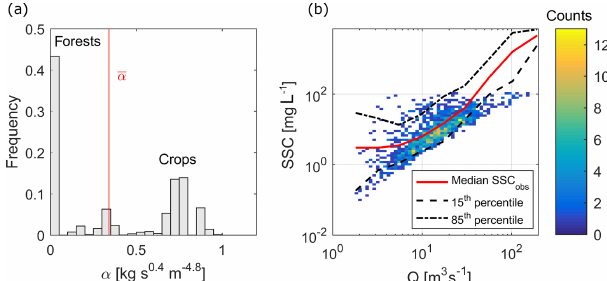
Figure 3. (a) Frequency distribution of the calibrated surface erodi- bility parameter α , with mean α indicated with the red line; (b) den- sity plot of the simulated SSC at outlet compared with measure- ments; the lines show the median (red) and 15th and 85th percentile (black dashed) of the